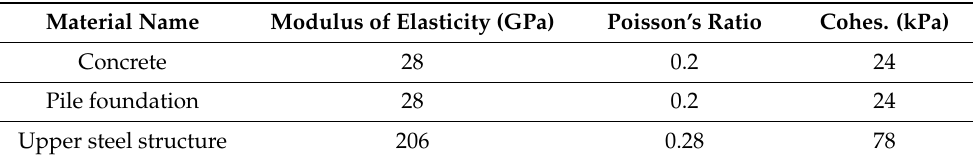
Table 2. Table of structural material parameters.